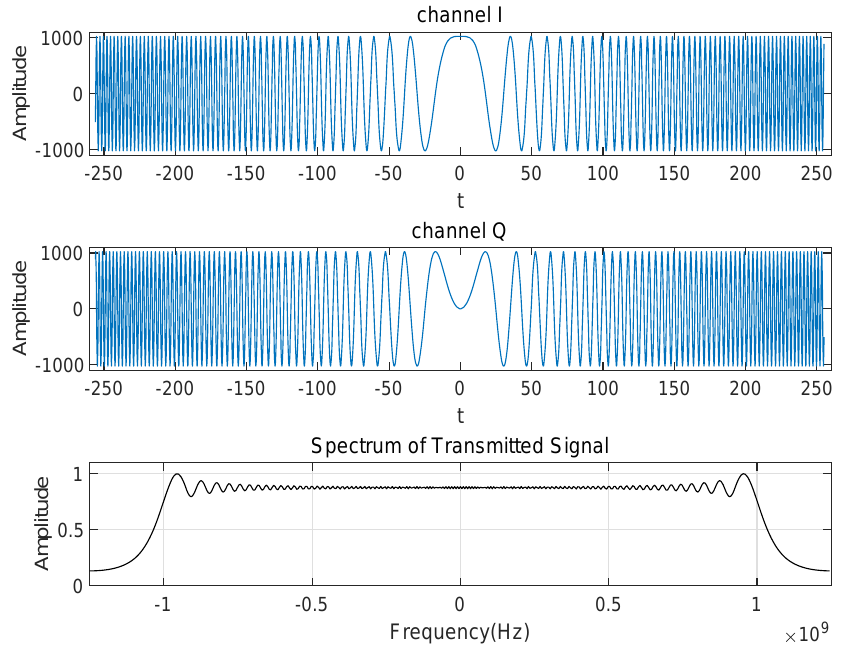
Figure 5. Chirp signal and